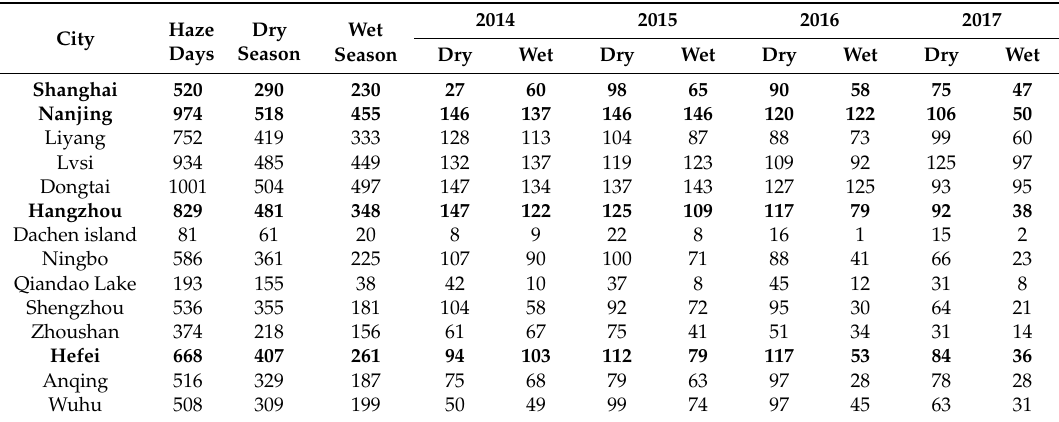
Table 1. The amount of haze days in each station over The Yangtze River Delta Urban Agglomeration